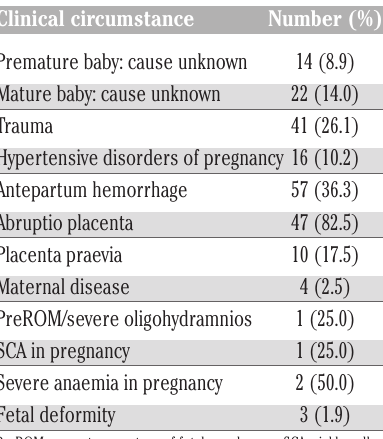
Table 4. Fetal determinants of stillbirths. Risk factor